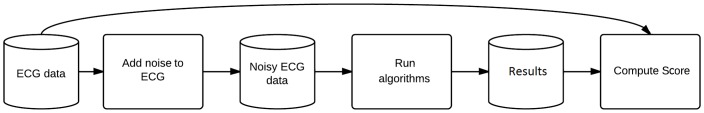
Evaluation process.